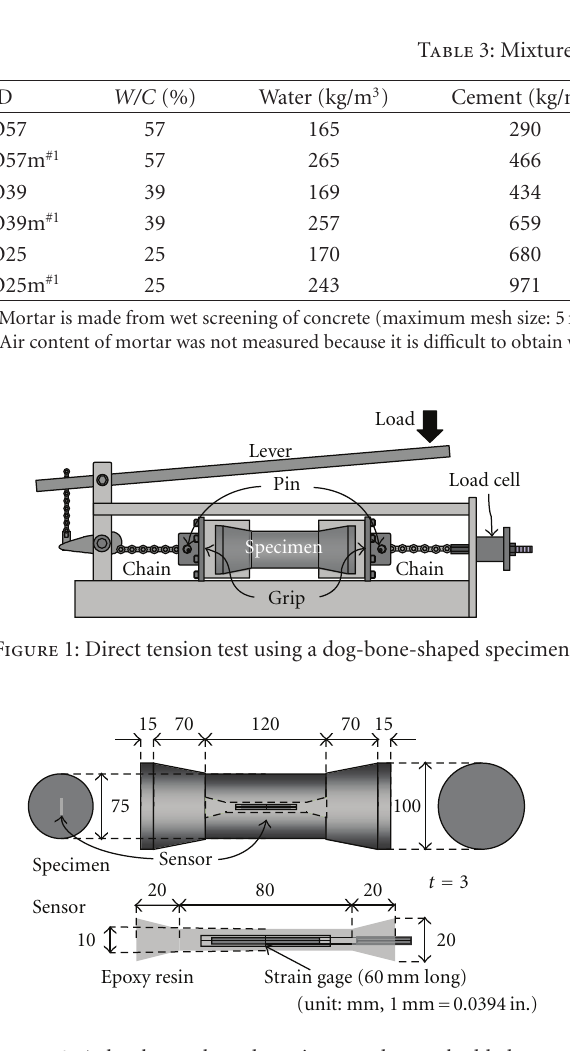
Figure 2: A dog-bone-shaped specimen and an embedded sensor.